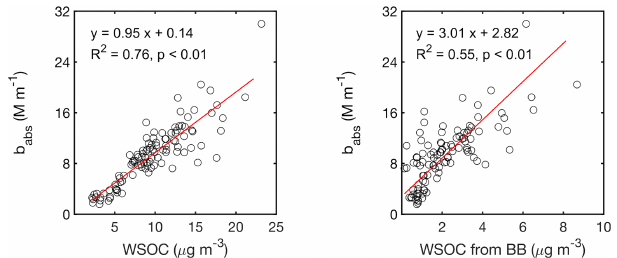
Figure 10. Correlations of water-soluble BrC absorption coefficient ( b abs ) and WSOC or WSOC from biomass burning (WSOC from BB) in PM 2 . 5 from 14 to 29 January 2015 in Nanjing. WSOC from BB is calculated with WSOC multiplied by